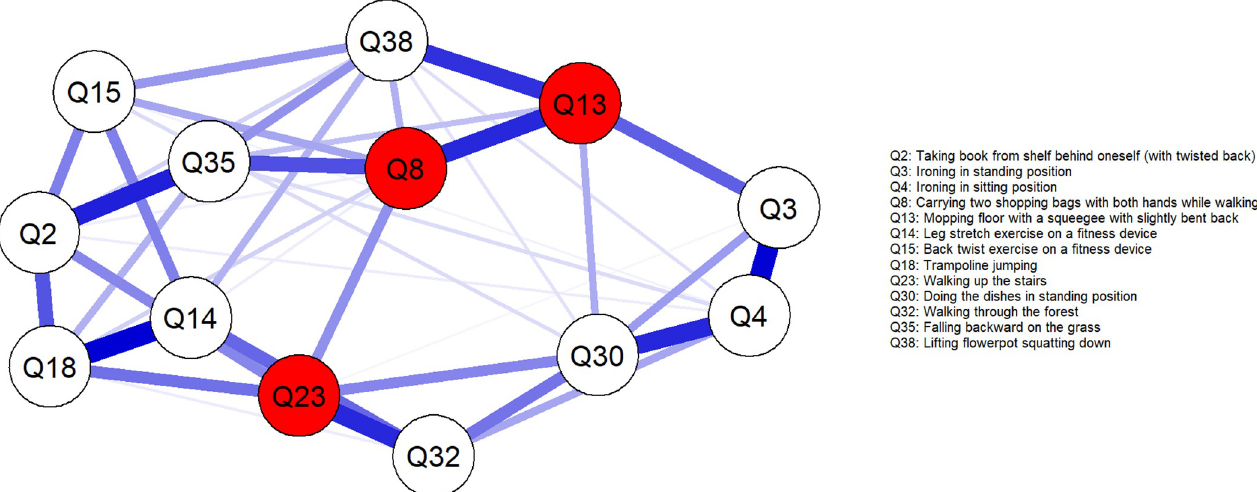
Fig 2. Network analysis of the association between items of the PHODA-SeV. (a) nodes with characters as item identifier, (b) nodes with images as item identifier. Edges represent connections between two nodes and are interpreted as the existence of an association between two nodes, adjusted for all other nodes. Each edge in the network represents either positive regularised adjusted associations (blue edges) or negative regularised adjusted associations (red edges). The thickness and colour saturation of an edge denotes its weight (the strength of the association between two nodes). Nodes colored red are those with a high Strength centrality